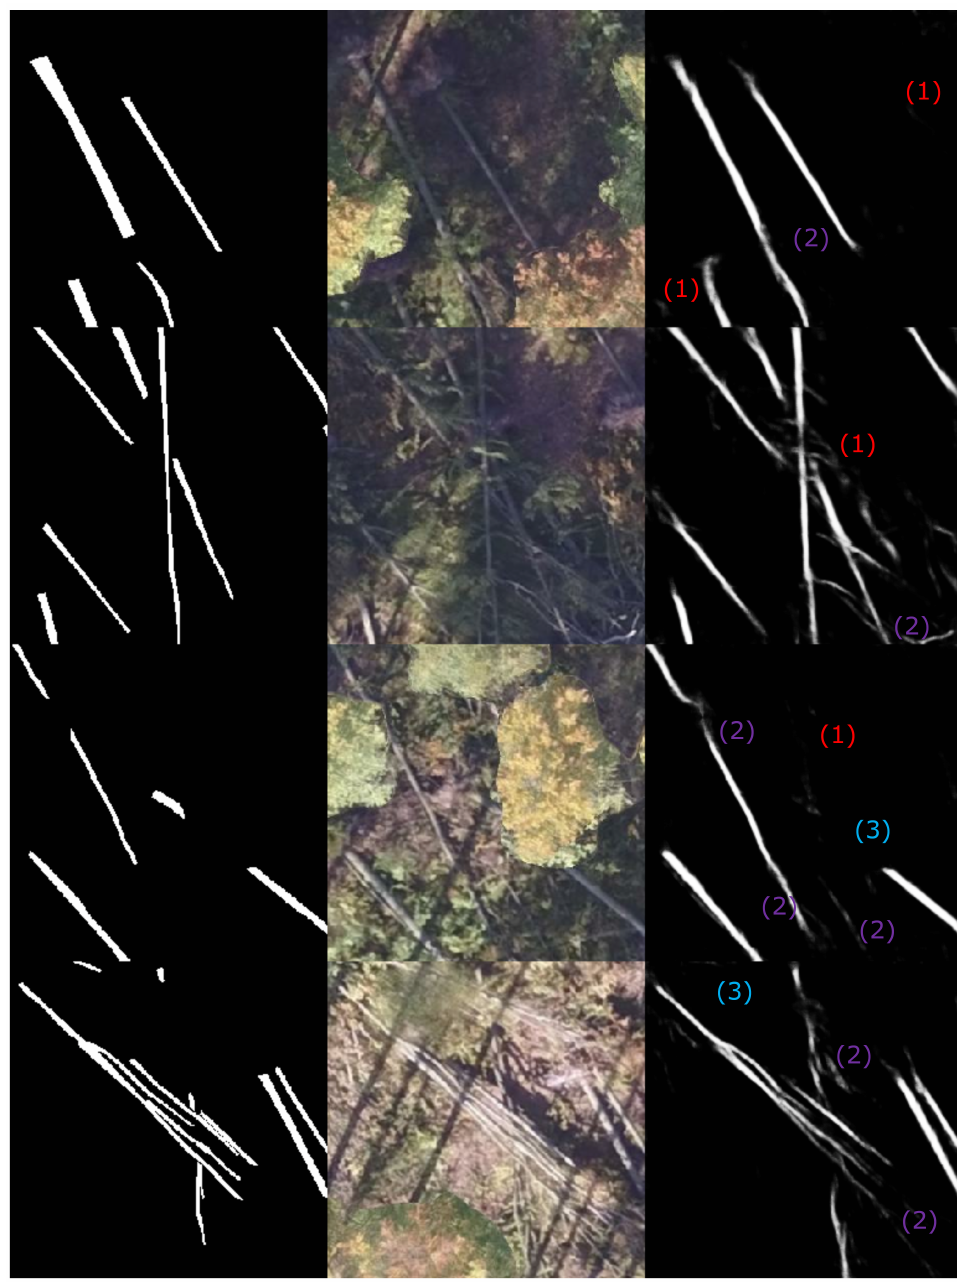
Figure 9. S2Mod50 predicted samples of the test dataset; left: tree mask; middle: test samples; right: predicted result. The amount of misclassified pixels stayed at the same level (1), the detected parts representing smaller branches and parts which were not masked was further increasing (2). Compared to the result of the S2Mod10 dataset, there was one additional part missing in the last sample